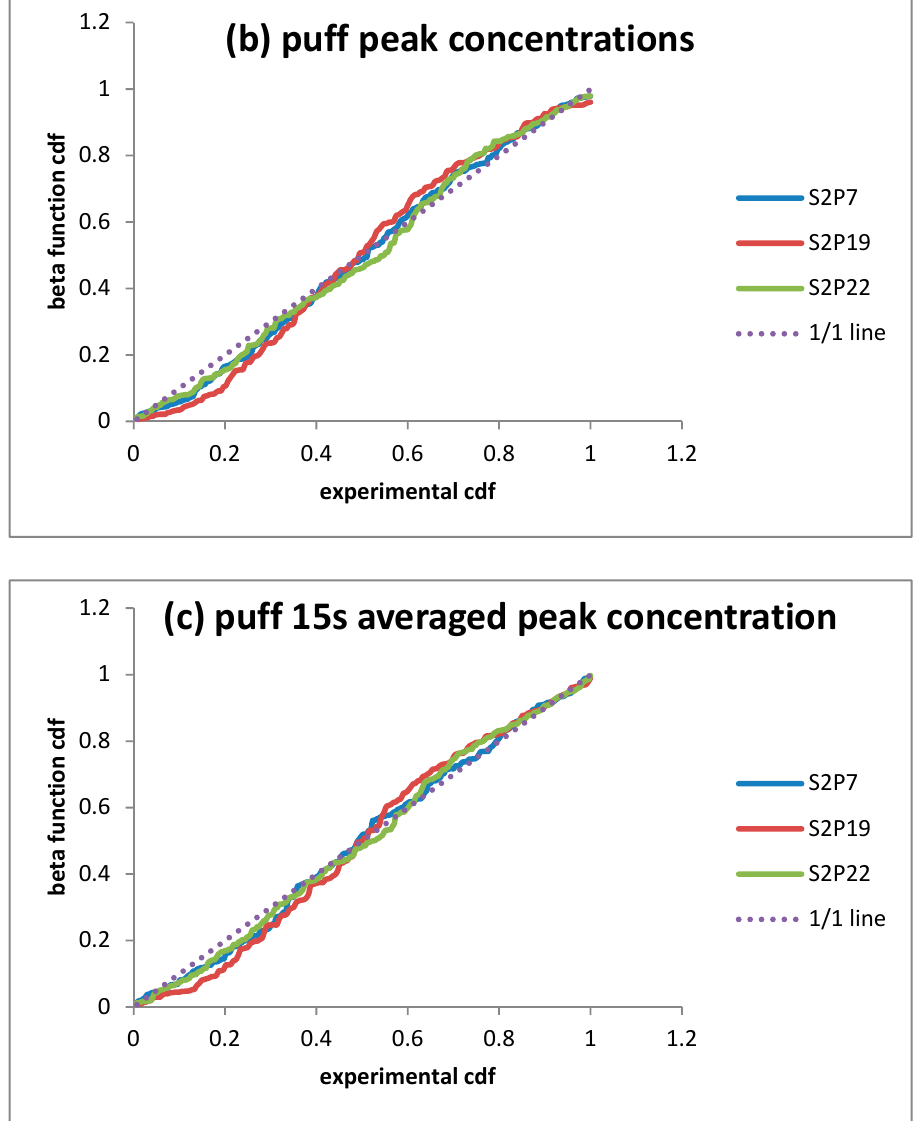
Figure 9. Puff releases: Beta function vs. experimental cumulative density function (cdf) for ( a ) dosage, ( b ) peak concentrations and ( c ) 15-s time-averaged peak concentrations.